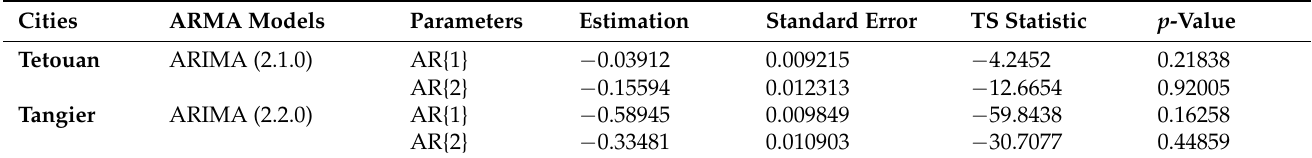
Table 4. Estimation of ARIMA model parameters for the prediction of daily global solar radiation of the two cities (Tetouan and